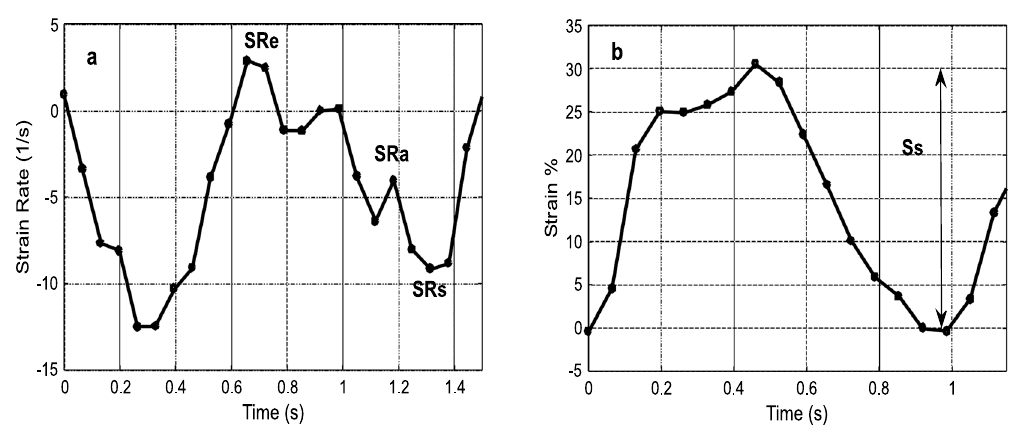
Figure 8. Fractional shortening obtained from the DIC analysis.